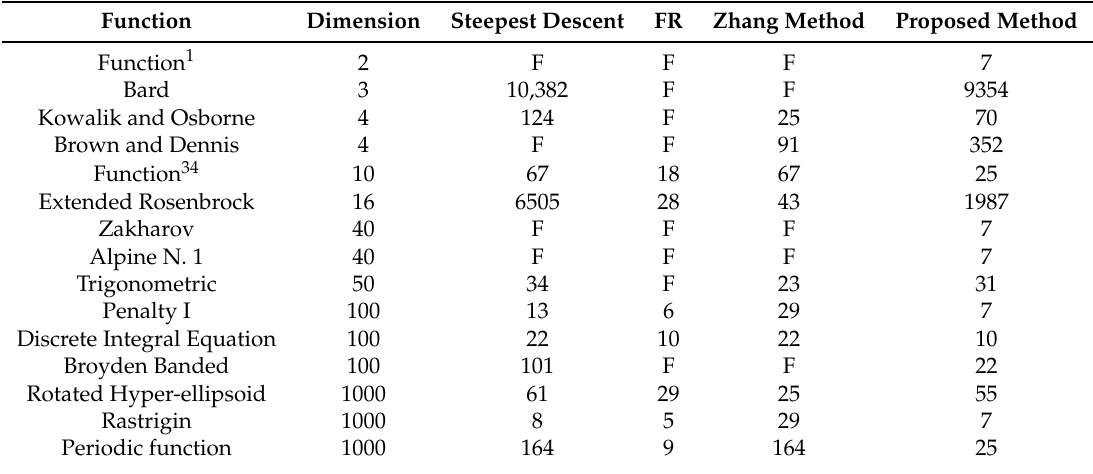
Table 4. The number of gradient evaluations (Ng) for different methods.